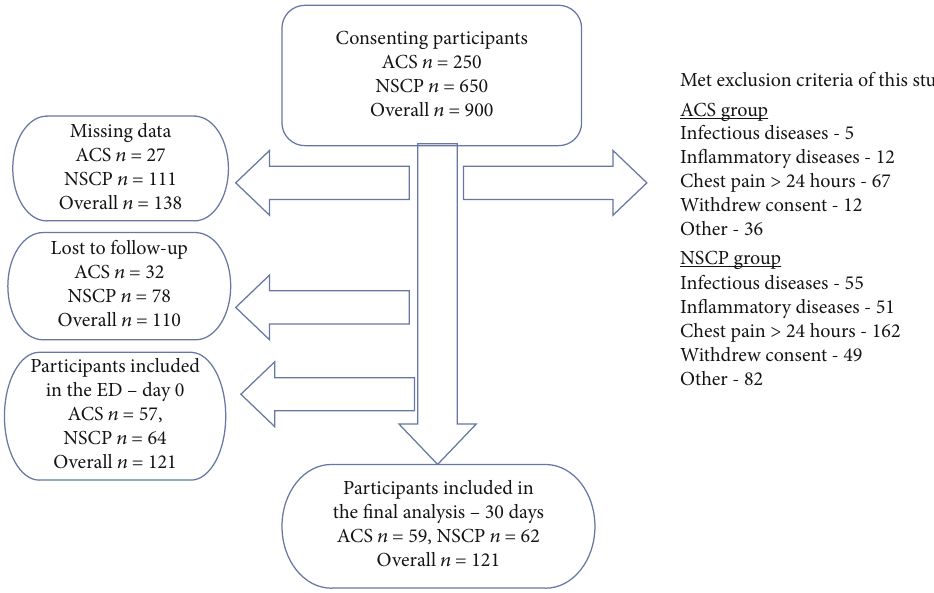
Figure 1: Flow chart of n = 900 patients presenting to the ED with suspected